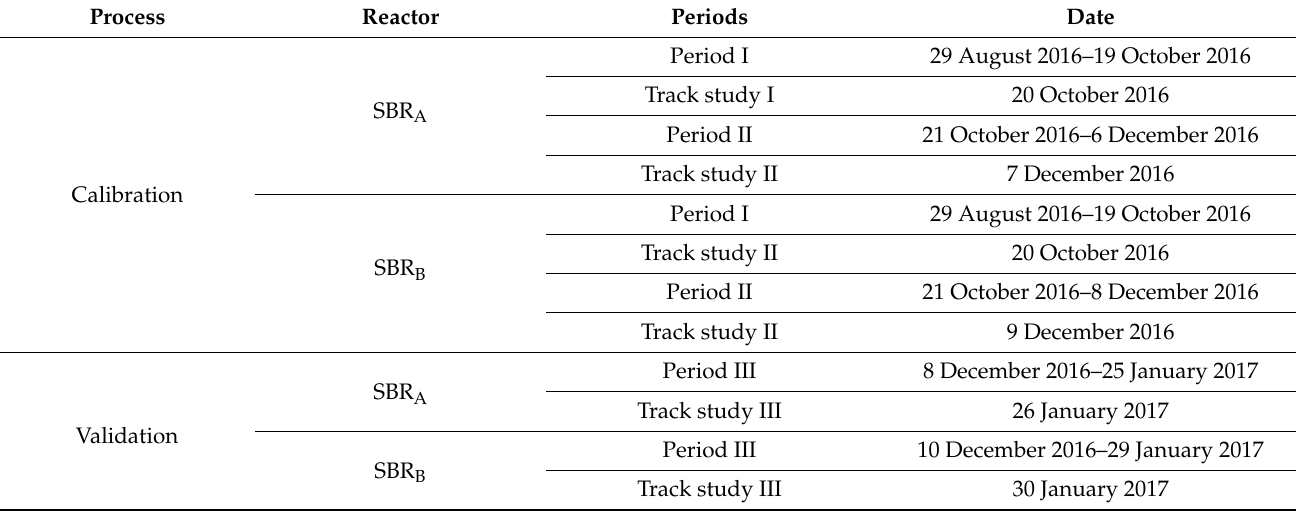
Table 4. Monitoring periods for model calibration and